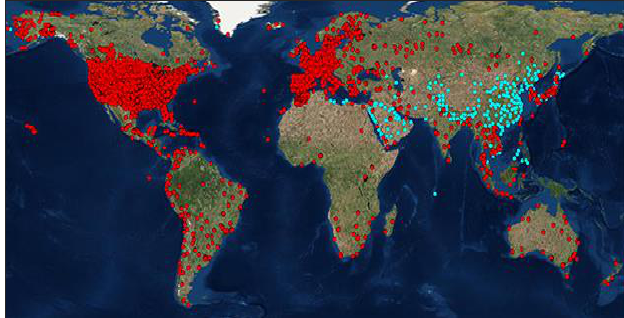
Figure 10. Global archive of GCP (red) and RSGCPs®